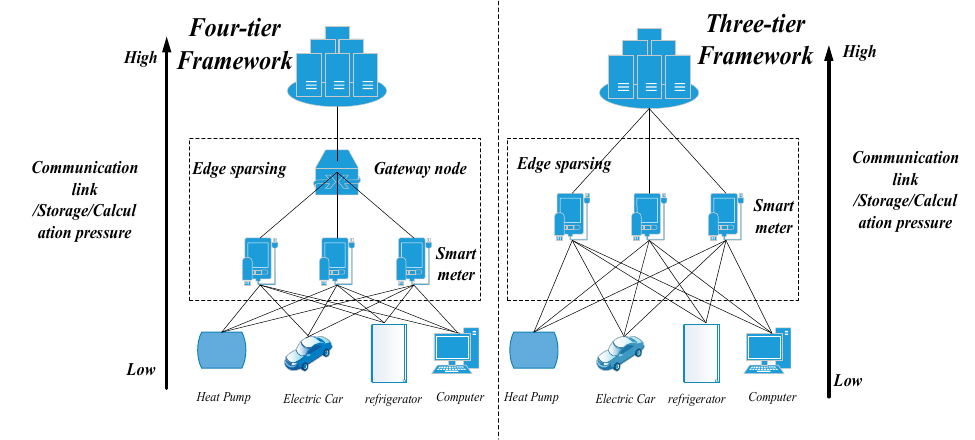
Figure 4. The edge sparse coding architecture for load data.